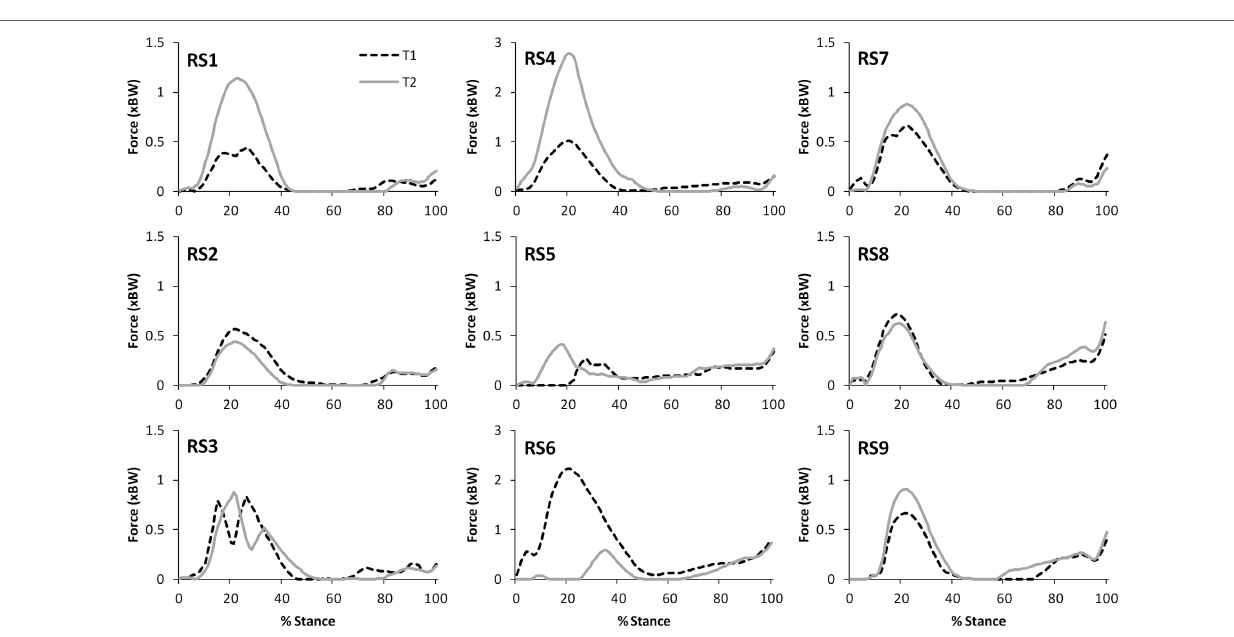
Peak PFJ and quadriceps and hamstrings forces occurred during early stance for all